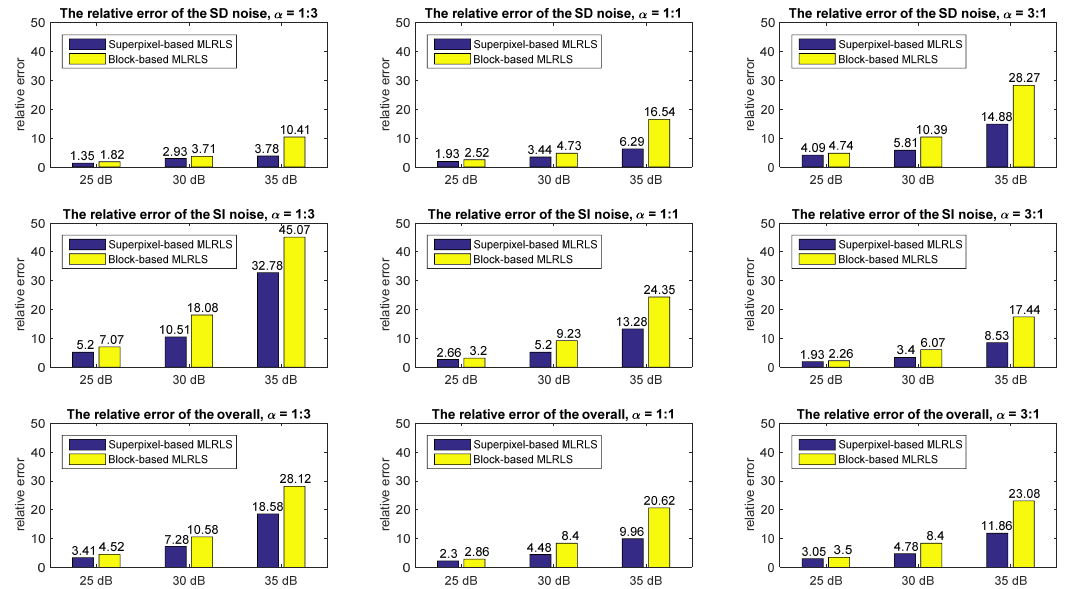
Figure 13. The optimal relative errors of the SD noise, the SI noise and the overall optimization for 1:2 spectral subsampling HSI.